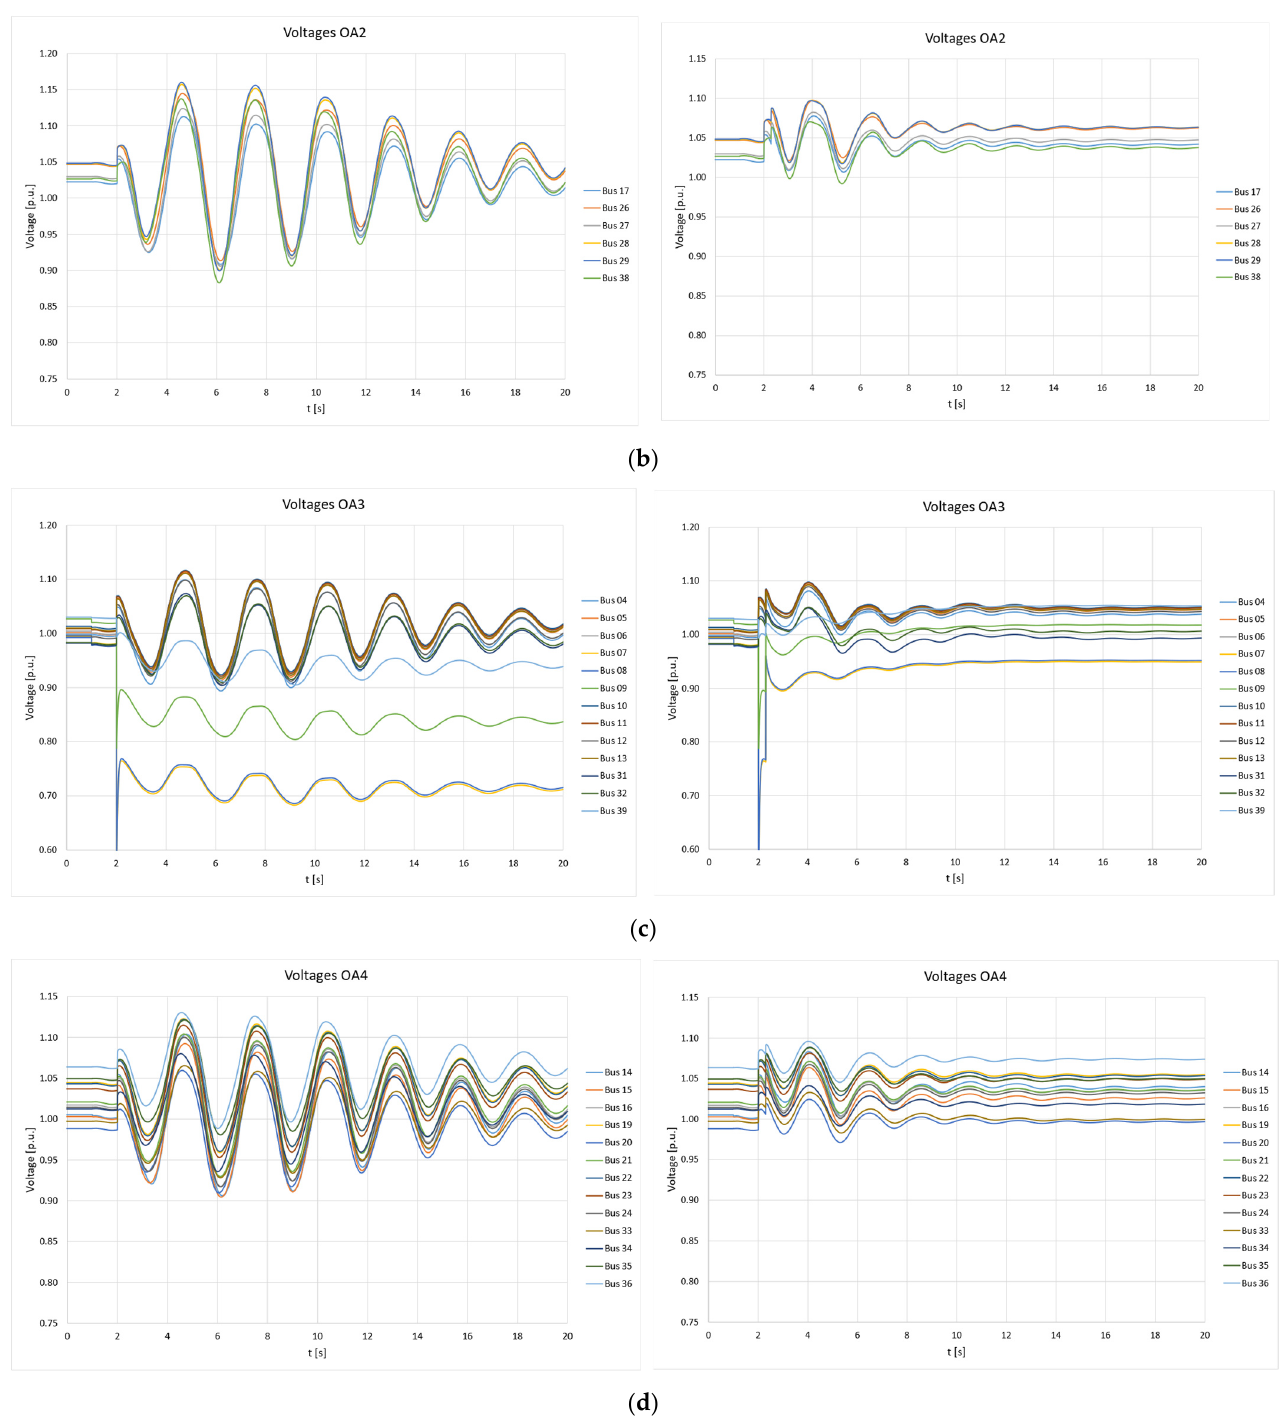
Figure 20. Voltage results without and with control actions (outages of lines 5–8 and 6–7). ( a ) Voltages OA1. ( b ) Voltages OA2. ( c ) Voltages OA3. ( d ) Voltages OA4